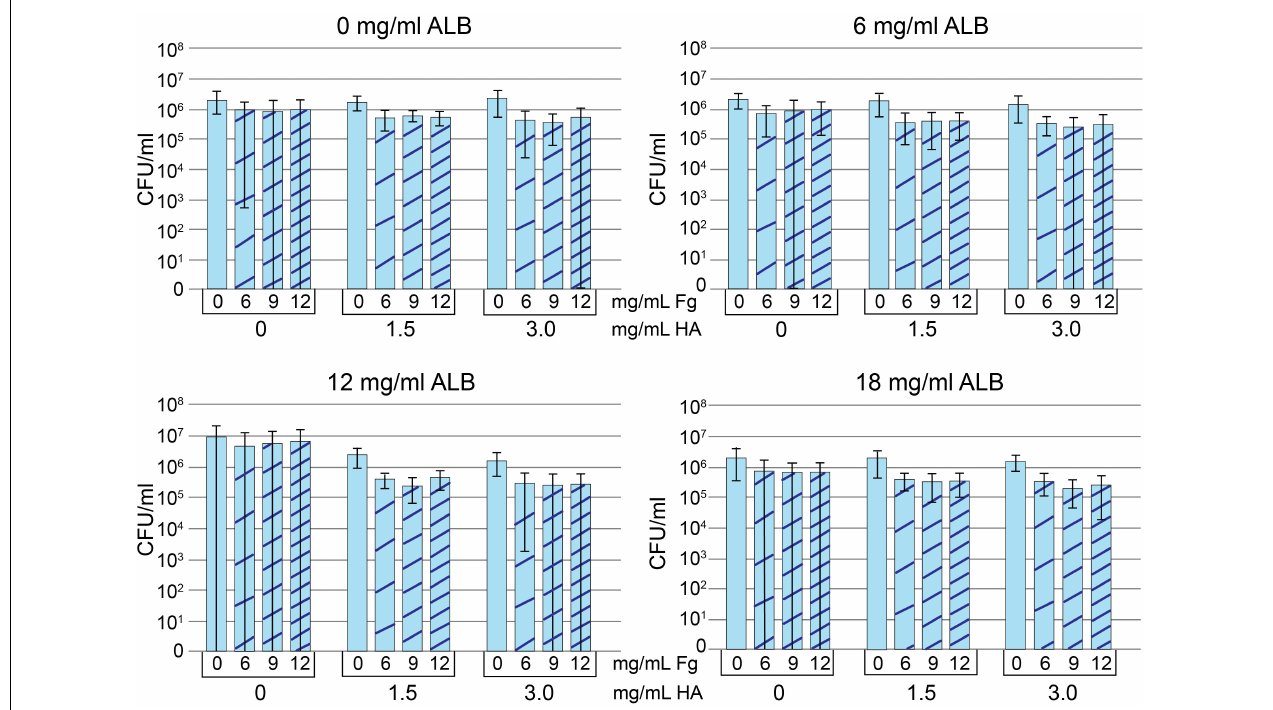
FIGURE 3 | Protein addition assay. Methicillin-susceptible Staphylococcus aureus (MSSA) CFU/ml after growth in Trypticase Soy Broth (TSB) containing 0, 6, 12, or 18 mg/ml albumin (Alb). Increasing concentrations of hyaluronic acid (HA) and fibrinogen (Fg) are indicated in each panel. Decreased CFU/ml is a marker of increased aggregation. Values graphed are means ± SD. Statistical analyses are included in the Supplementary Material A1 ( n = 8–9/condition).